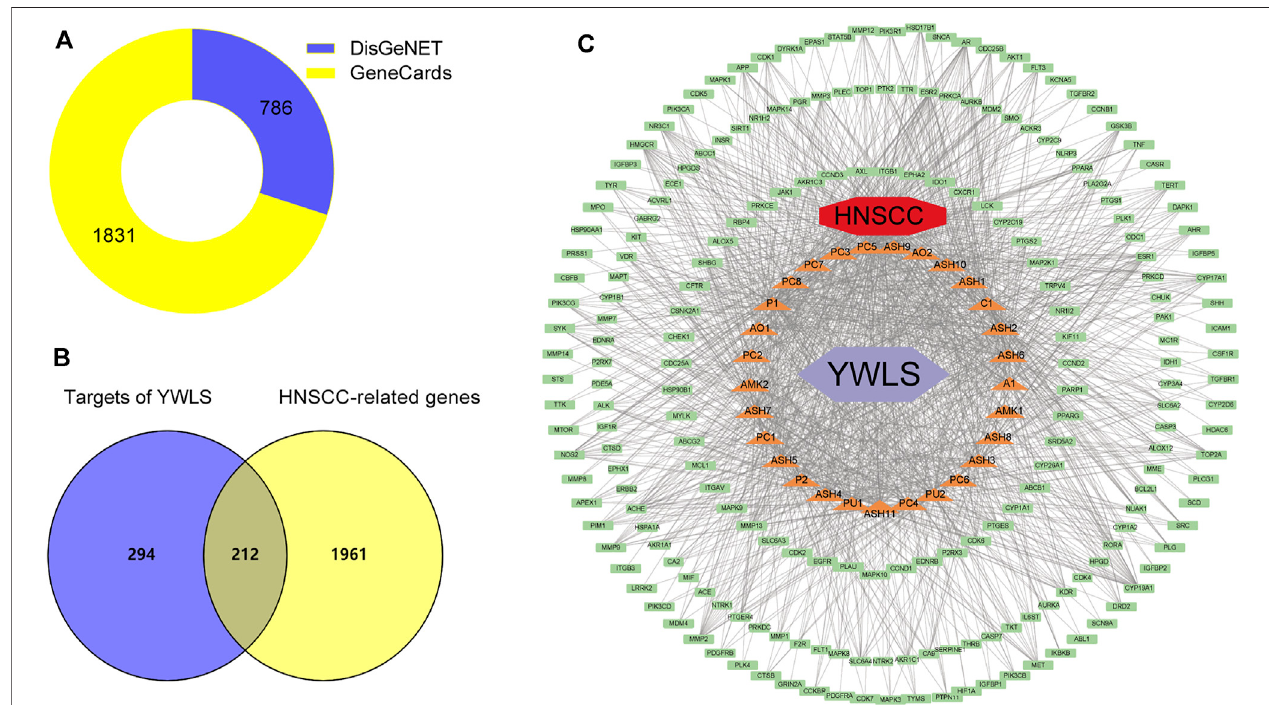
FIGURE 2 | Construction of compound-target-disease network. (A) . Screening of head and neck squamous cell carcinoma related targets from DisGeNET and GeneCards databases. (B) The Venny plot of 212 potential targets. (C) The active component-target-disease network. The red diamond represented the disease; the light green rectangle represented intersecting targets; the light purple diamond represented YWLS; the orange triangle represented active compounds (C1, MOL000359; AO1, MOL002464; AO2, MOL000862; P1, MOL000279; P2, MOL000282; PU1, MOL000796; PU2, MOL000820; PC1, MOL000273; PC2, MOL000276; PC3, MOL000280; PC4, MOL000285, PC5, MOL000287; PC6, MOL000290; PC7, MOL000291; PC8, MOL000292; AMK1, MOL000072; AMK2, MOL000033; A1, MOL000358; ASH1, MOL000354; ASH2, MOL004609; ASH3, MOL005573; ASH4, MOL007274; ASH5, MOL008039; ASH6, MOL008040;